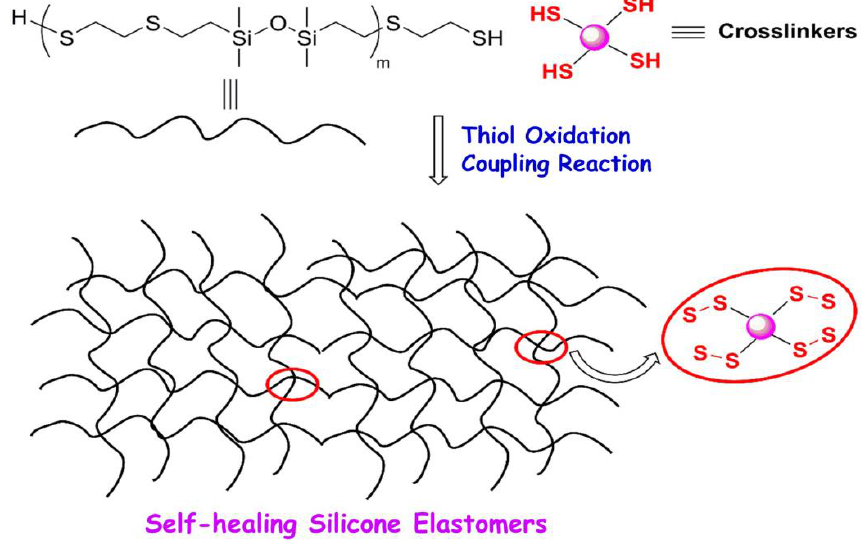
Figure 19. Synthesis of disulfide-linked SEs. Reprinted under the terms and conditions of the Creative Commons Attribution (CC BY) license from Polymers 2021, 13 , 3729 [79].